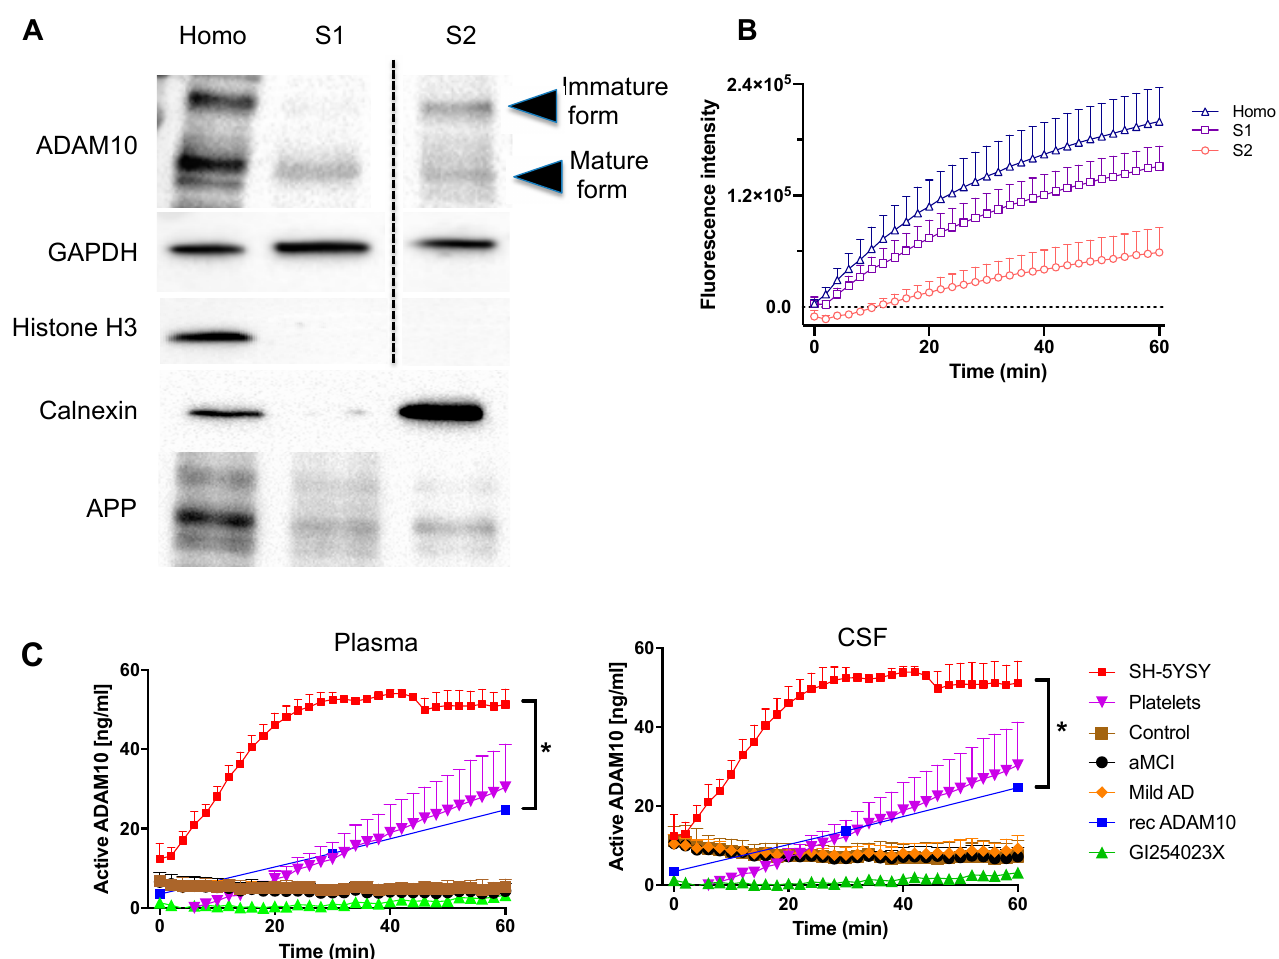
Figure 3. Analysis of ADAM10 activity in SH-5YSY neuroblastoma cells, platelets or CSF samples. ( A ) Western blotting analyses of subcellular fractions of SH-SY5Y human neuroblastoma cells; samples were probed for ADAM10 (immature form 85 kDA, mature form 65 kDa), GAPDH (37kDa) and Histone H3 (17kDa), Calnexin (90 kDa) and APP (106-110 kDa). ( B ) Graph reporting ADAM10 activity monitored for 60 min of reaction in the same fractions described in ( A ). The activity of ADAM10 was evaluated using a fluorogenic peptide as described in methods. ( C ) ADAM10 activity in CSF (rightmost graph) and in plasma (leftmost graph) of control cognitively healthy (control), amnestic mild cognitive impairment (aMCI) and mild Alzheimer’s disease (Mild AD) groups. The ADAM10 activity was also analyzed in SH-5YSY neuroblastoma cells, platelet samples and recombinant ADAM10. A specific inhibitor for ADAM10 GI254023X was incubated with platelets before the addition of substrate to demonstrate that the majority of the activity in samples was due to ADAM10 (* p < 0.0001). Two-Way ANOVA and Kruskal-Wallis test. Graph Pad Prism 8.